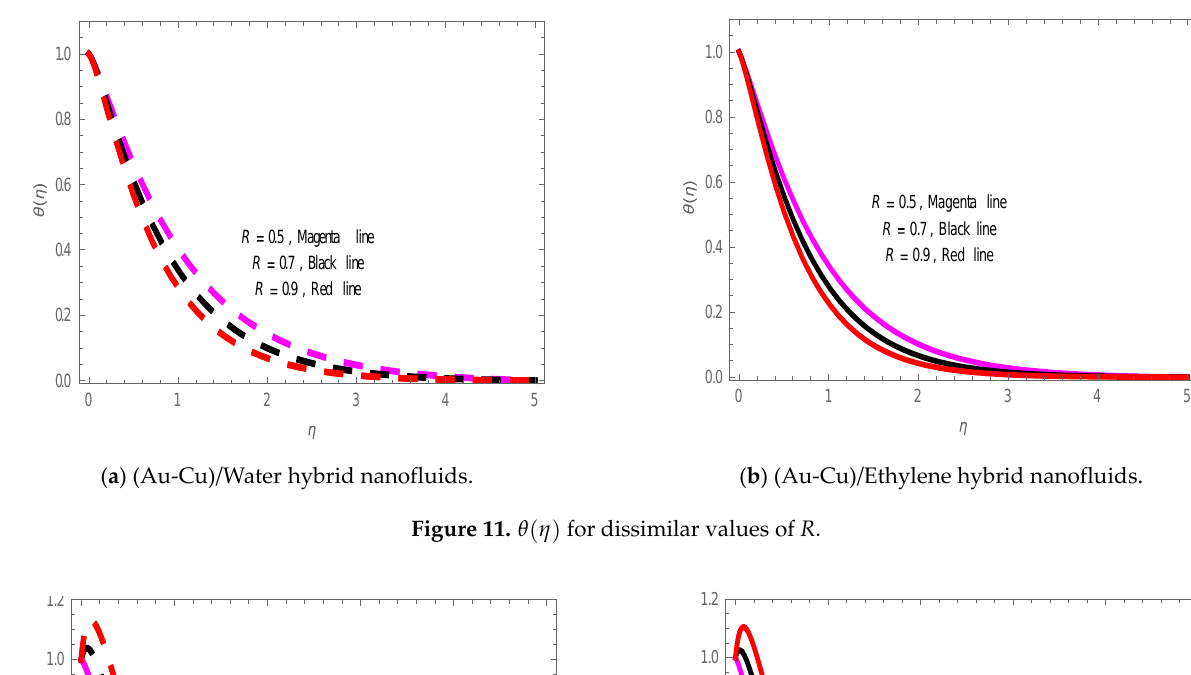
Figure 10. 𝜃(𝜂) for dissimilar values of m.